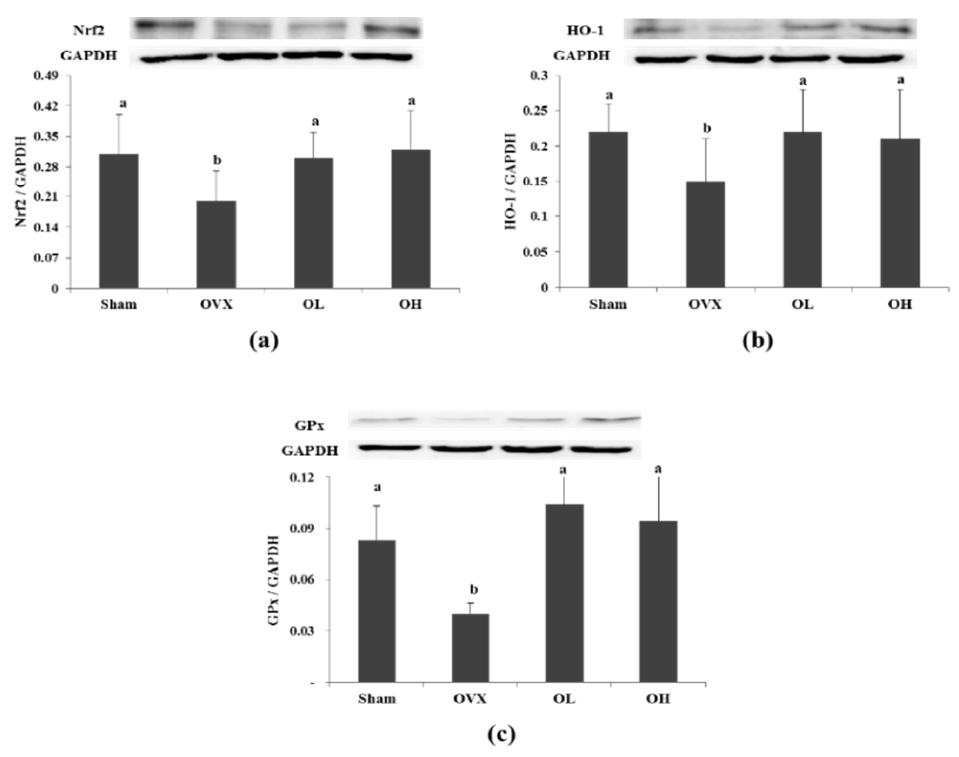
Figure 7. Protein expression of Nrf2, HO-1, and GPx in liver of each group. ( a ) Nrf2; ( b ) HO-1; ( c ) GPx. Values are mean ± SD ( n = 7 for each group); the different letters (a > b > c) within a column indicate significant differences ( p < 0.05) determined by Duncan’s multiple range test; Sham, the non-OVX control; OVX, the OVX-control; OL, the OVX + 100 mg/kg b.w. of hawthorn extract; OH, the OVX + 200 mg/kg b.w. of hawthorn extract; Nrf2, Nuclear factor erythroid 2–related factor; HO-1, Heme oxygenase-1; GPx, Glutathione peroxidase; GAPDH, Glyceraldehyde-3-phosphate dehydrogenase.